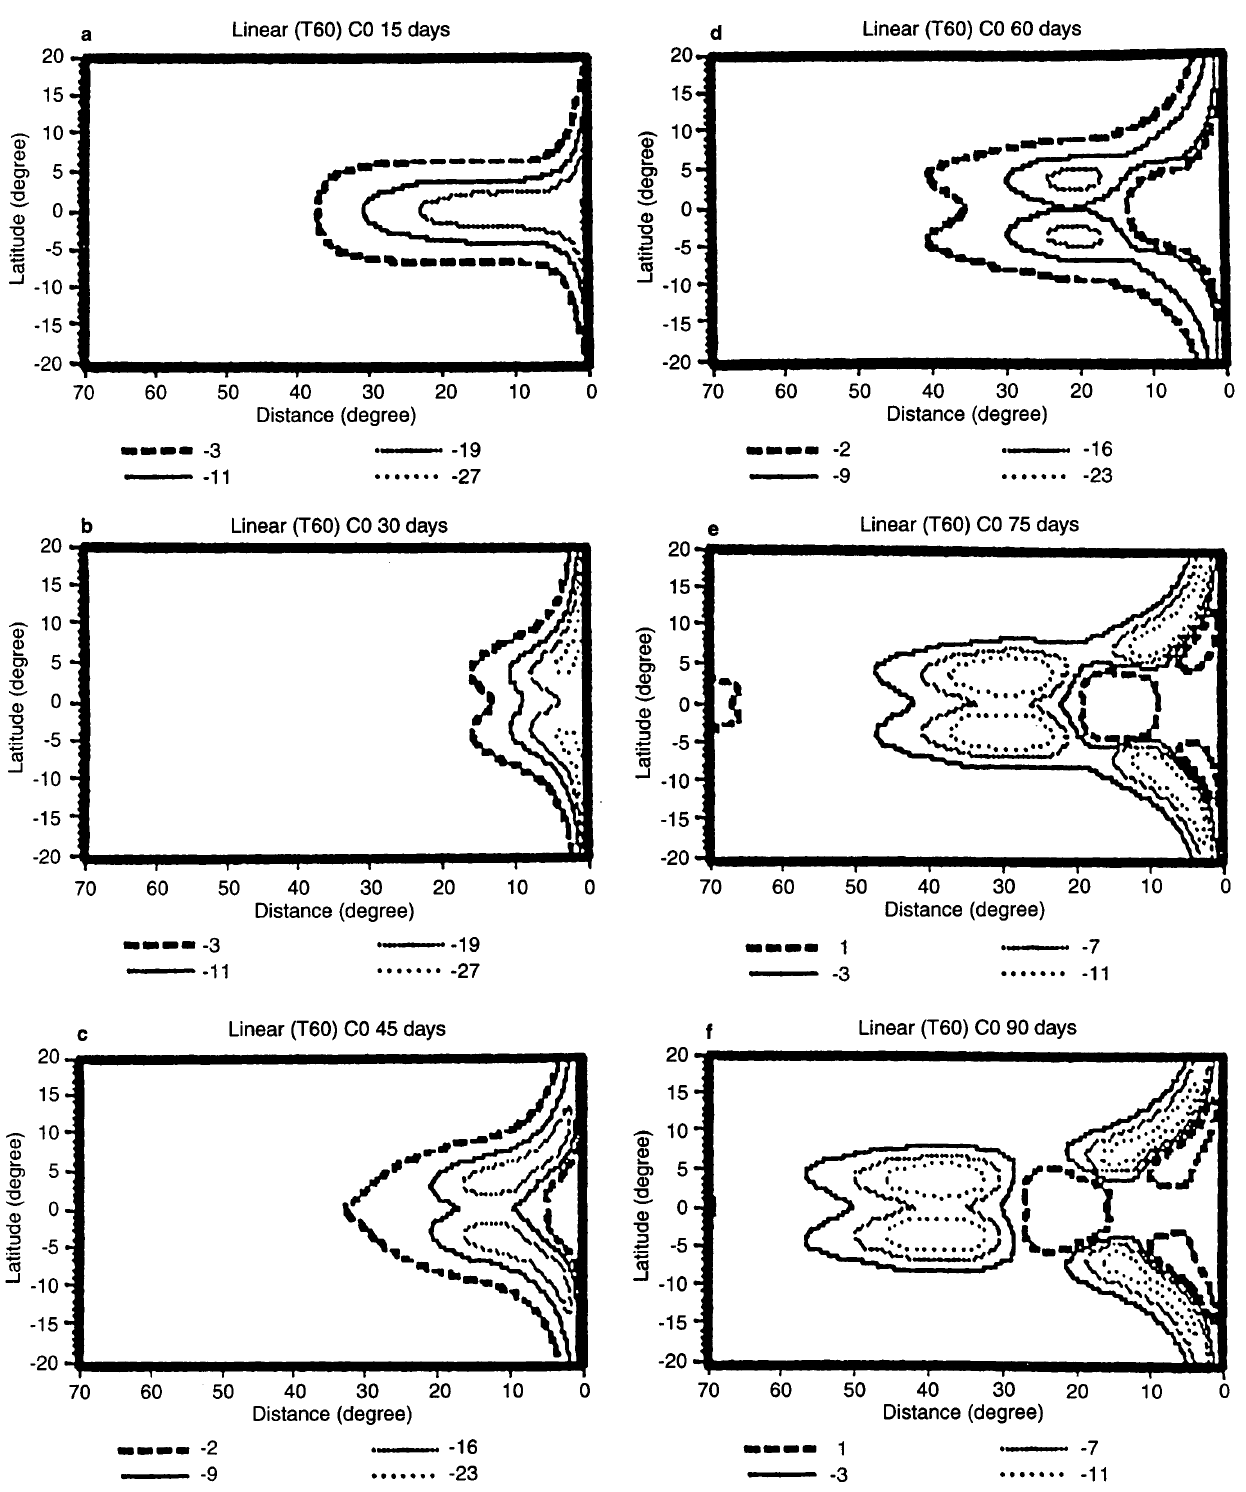
Fig. 3a–f. Sequential patterns of the linear interface anomaly (in m), at (a) 15, (b) 30, (c) 45, (d) 60, (e) 75 and (f) 90 days. C0. T (cid:136)